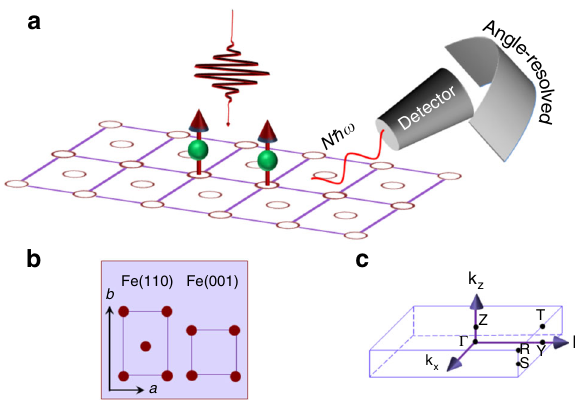
Fig. 1 High-order harmonic generation in ferromagnetic materials. a An intense laser pulse excites a ferromagnetic iron monolayer and generates high-order harmonics. The harmonic has spin signature on the spectrum and can be dispersed in the crystal momentum space, so the harmonic peak can be assigned to a unique transition between occupied and unoccupied states. Higher-order harmonics are more sensitive to the band structure change than lower-order ones, thus making HHG an ideal tool for spin- resolved detection. b Brillouin zone of a simple orthorhombic structure.